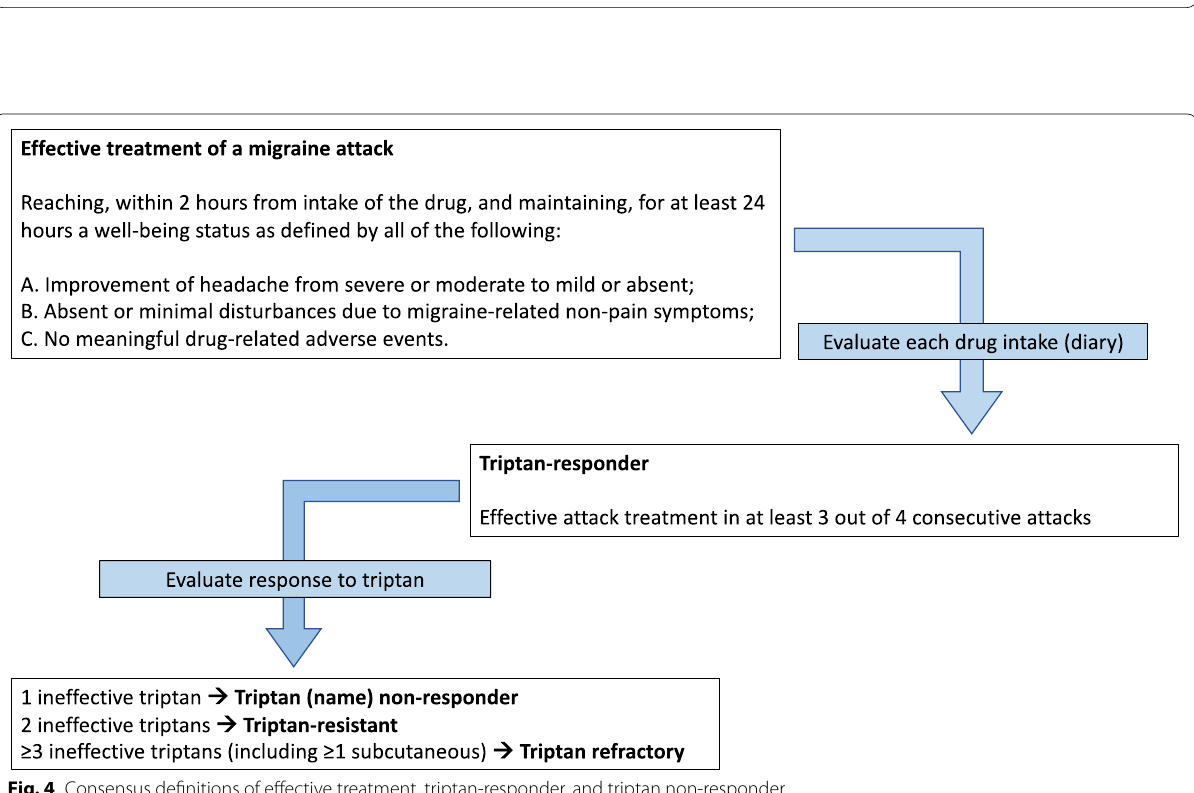
Fig. 3 Decision aid to define a patient as responder or non‑responder to a triptan based on the evaluation of the response to two‑to‑four consecutive attacks